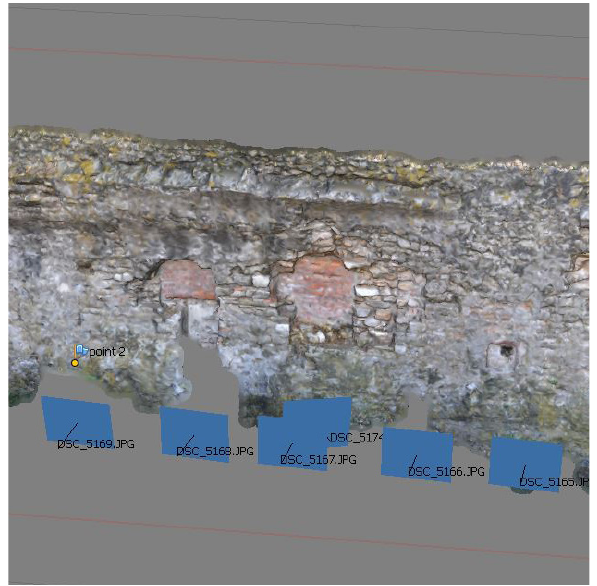
Figure 7. Perimetral wall in the Agisoft PhotoScan environmentFigure 6. Two levels of the excavation area